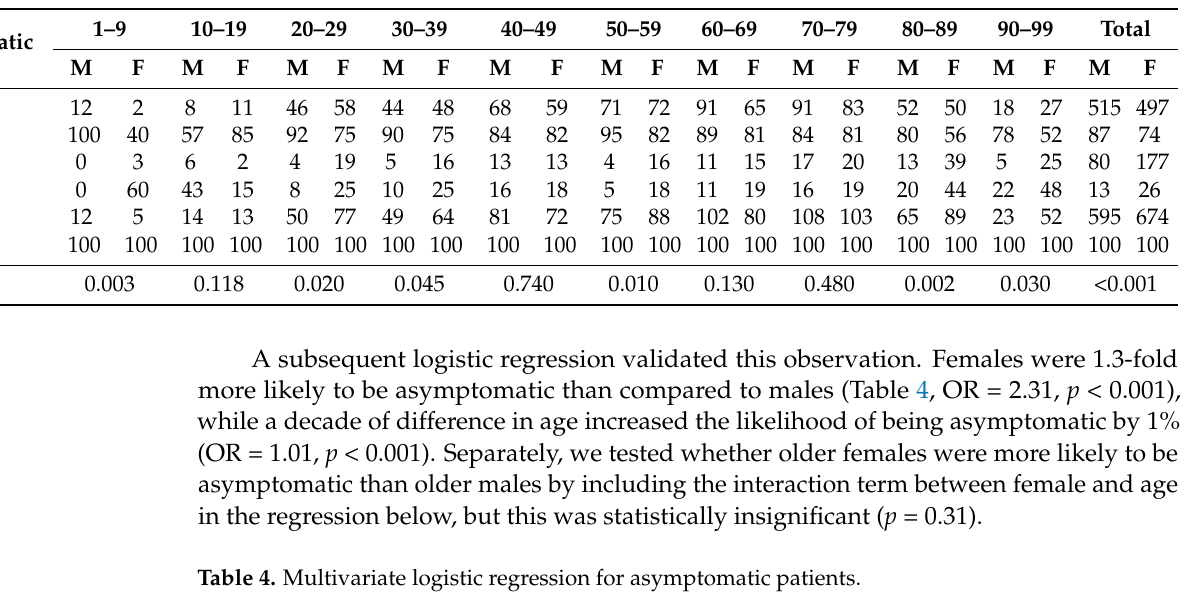
Table 3. Asymptomatic patients by age and sex.